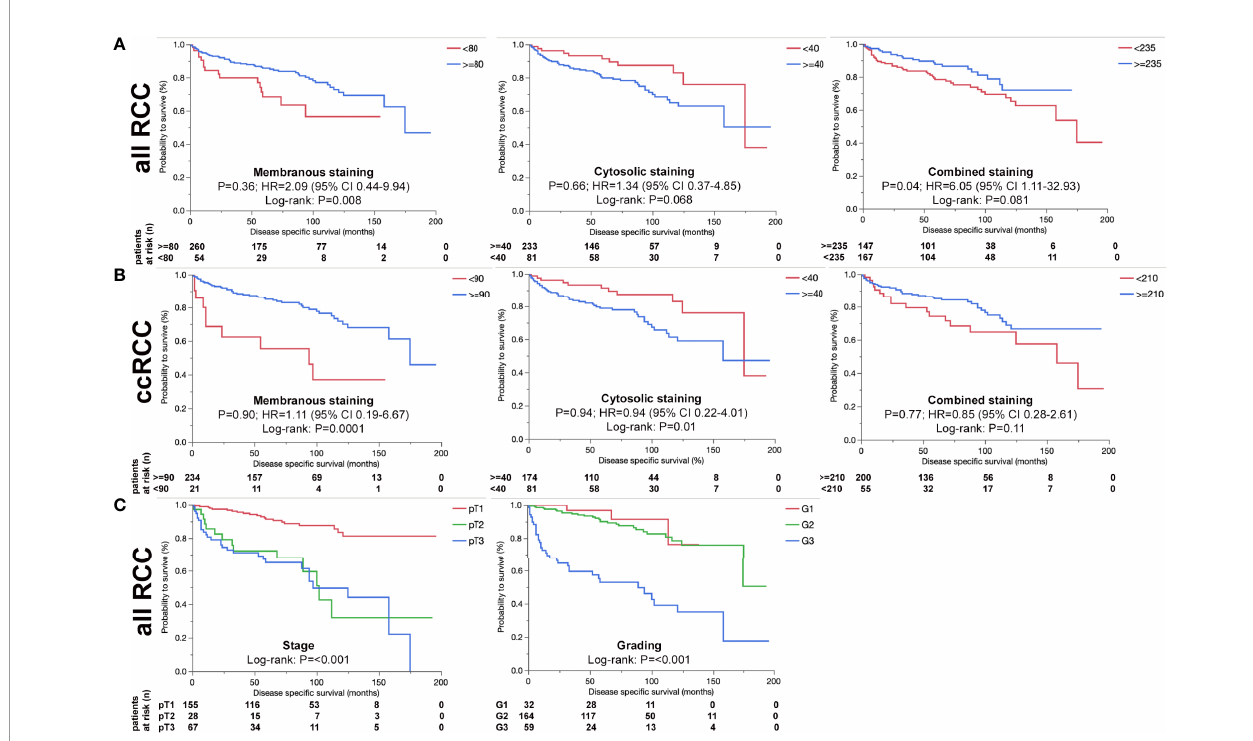
FIGURE 4 | ERV-K env and associations with RCC patient survival. (A) Kaplan-Meier survival curves {Disease speci fi c survival (DSS) in months} of all RCC patients as represented from the TMA showing the association of ERV-K env membranous, cytosolic and total protein expression (combined) according to the H-score (> blue or < red). Note that ERV-K env total protein shows a signi fi cance for longer DSS survival. (B) Kaplan-Meier survival curves (Disease speci fi c survival in months) of ccRCC patients represented from the TMA showing the association of ERV-K env membranous, cytosolic and total protein expression (combined). (C) Kaplan-Meier survival curves of all RCC patients represented from the TMA according to staging and grading. For staging the following regressions were: pT2 vs pT1: HR 13.7; p= 0.0002; 95%-CI: 3.39 - 55.33; pT3 vs pT1: HR 6.36; p= 0.03; 95%-CI: 1.17 - 34.71; pT3 vs pT2: HR 0.46; p= 0.32; 95%-CI: 0.1 – 2.08. For Grading the regressions were: G3 vs G2 + G1: HR 2.28; p= 0.23; 95%-CI: 0.6 - 8.71. For all curves log rank p-values are shown as well as multivariable adjusted Hazards ratios (HR) calculated by using Cox regression models. Partitioning tests (mono-forest prediction) were performed to determine “ cut-off ” levels for each tumor subtype because of known biological differences between the histological RCC tumor